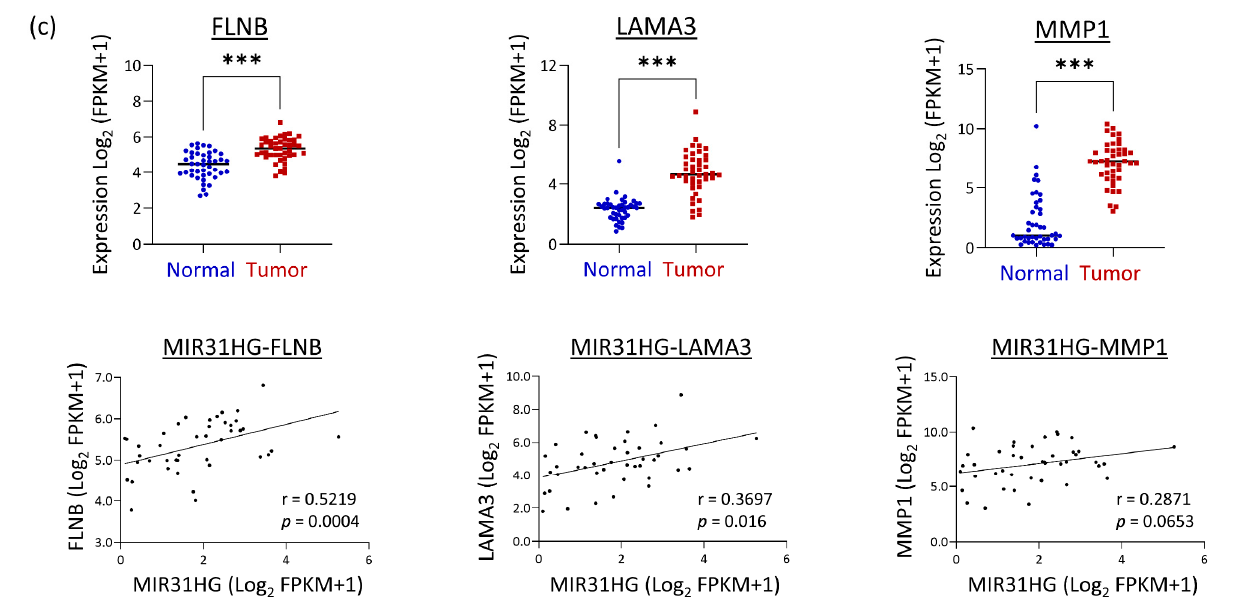
Figure 6. MIR31HG regulates arecoline-induced cellular invasion in HNC cells. The Matrigel invasion assay was performed to analyze the silencing effect of lncRNAs in the regulation of arecoline- induced cell invasion. ( a ) The effect of invasion ability is modulated by MIR31HG silencing. ( b ) The expressions of invasion associated genes (FLNB, LAMA3, and MMP1) in response to MIR31HG silencing in three HNC cell lines, as determined by RT-qPCR analysis. ( c ) The correlative expressions of MIR31HG with three invasion-associated genes. (*: p < 0.05, **: p < 0.01, ***: p < 0.001). si-M, si-MIR31HG; Are,